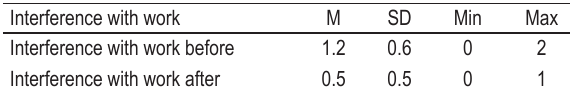
TABLE 9. Descriptive values of interference variables before and after